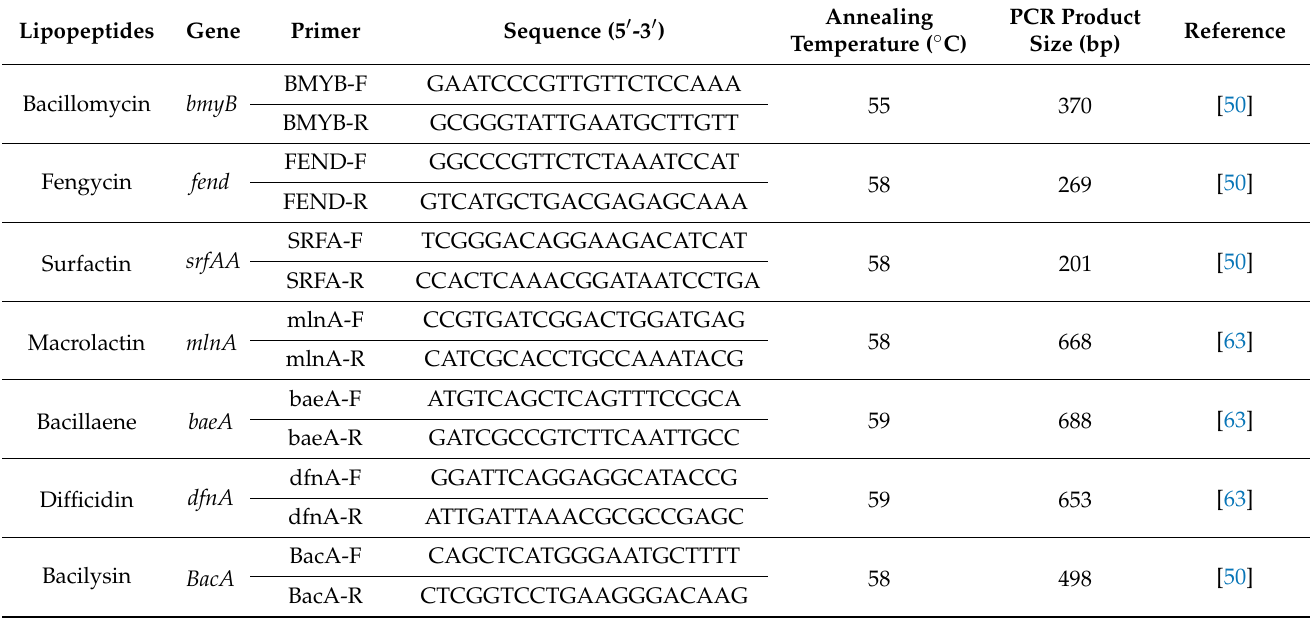
Table 2. The list of primers used to detect the genes involved in the biosynthesis of lipopeptides, polyketides, and